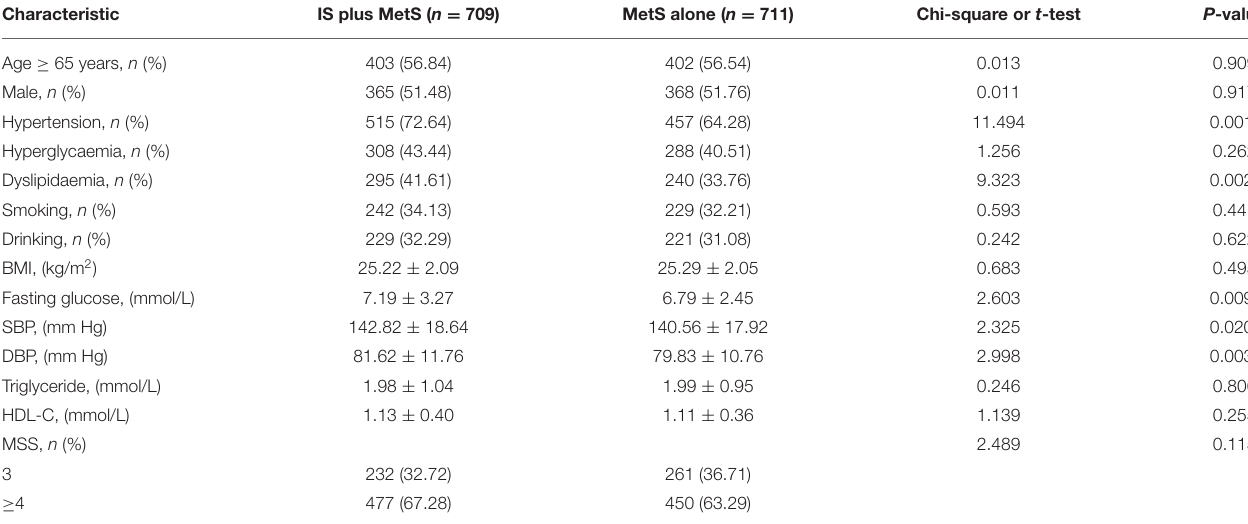
TABLE 1 | Baseline characteristics of